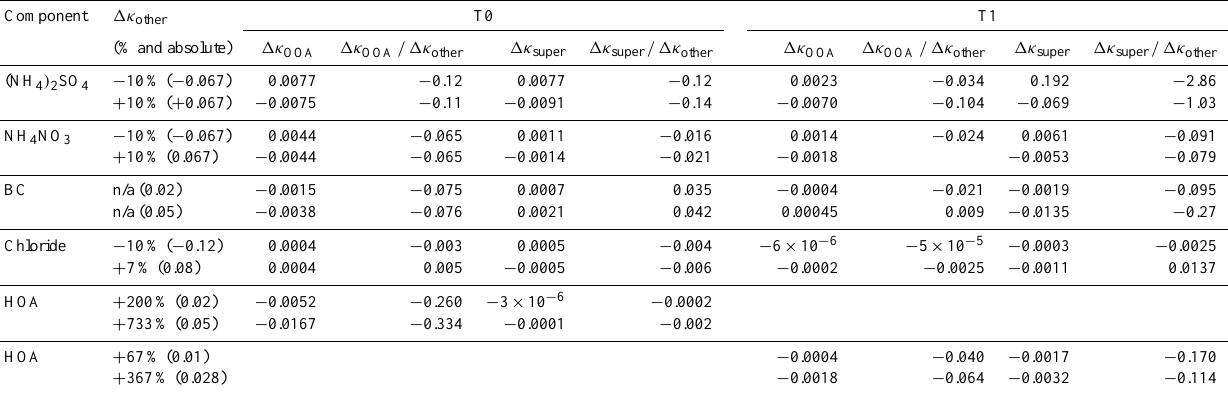
Table 2. Change in absolute model retrieved κ OOA or κ super for a given perturbation in the assumed hygroscopicities for other particle components ( κ other ), along with sensitivities shown as (cid:49)κ OOA /(cid:49)κ other and (cid:49)κ super /(cid:49)κ other . Component (cid:49)κ other T0